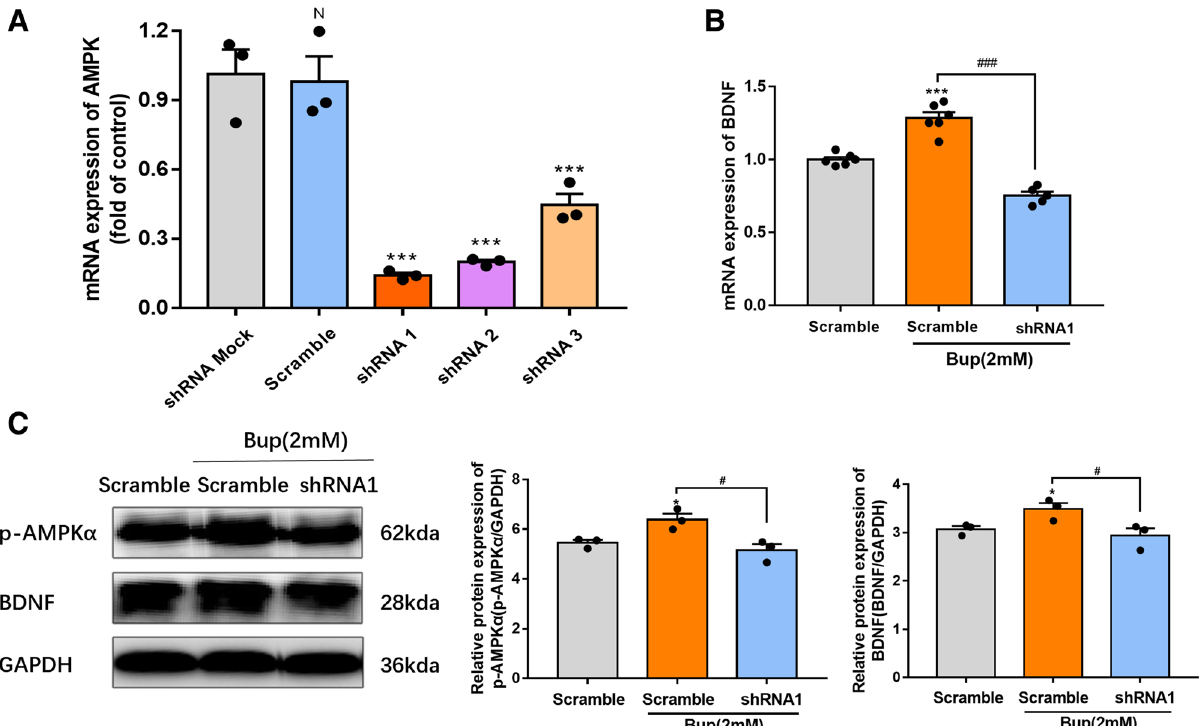
Figure 4. AMPK shRNA reversed the increase in BDNF by bupivacaine. ( A ) q-PCR analysis of AMPK mRNA expression in astrocytes after treatment with LV- AMPK-shRNA (shRNA1, shRNA2, shRNA3). ( B ) The expression of BDNF mRNA was measured by qPCR after bupivacaine and shRNA treatment. ( C ) Representative western blotting and relative expression of p-AMPKα and BDNF in astrocytes after bupivacaine and shRNA